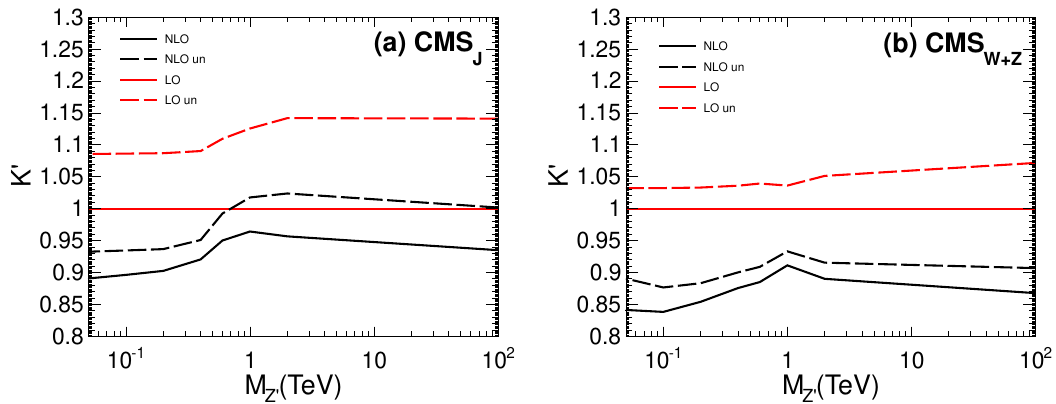
Figure 7. Exclusion limits on NSIs using different theoretical predictions normalized to those using leading order predictions without theoretical uncertainties, as a function of the mass of Z 0 . The left (right) plots corresponds to constraints from CMS mono-jet (mono- W/Z ) measurement.